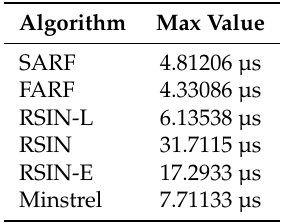
Table 3. Maximum values of the execution time of the selected